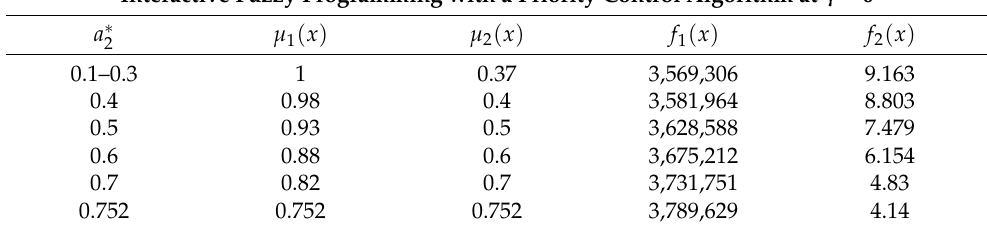
Table 7. Possible solutions to the problem by interactive fuzzy programming with a priority con- trol